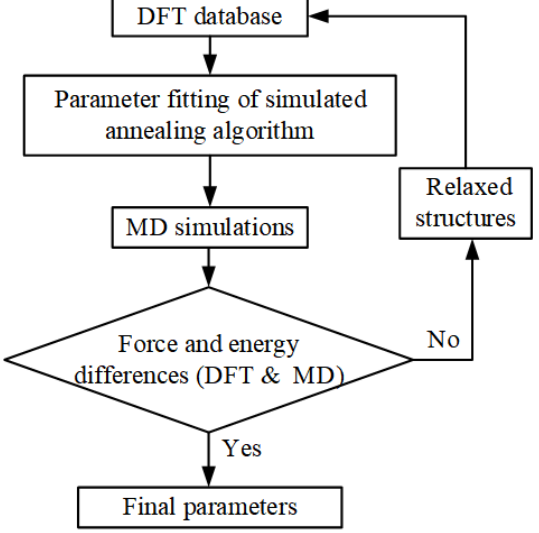
Figure 2. Parameter fitting protocol performed using the Simulation Optimization Algorithm.